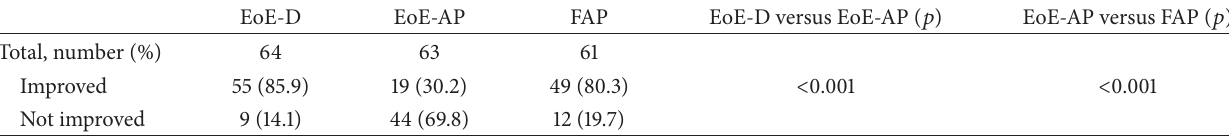
Table 3: Symptom score change, dysphagia for EoE-D and abdominal pain for EoE-AP and FAP, baseline versus follow-up. EoE-D EoE-AP FAP EoE-D versus EoE-AP ( 𝑝 ) EoE-AP versus FAP ( 𝑝 )